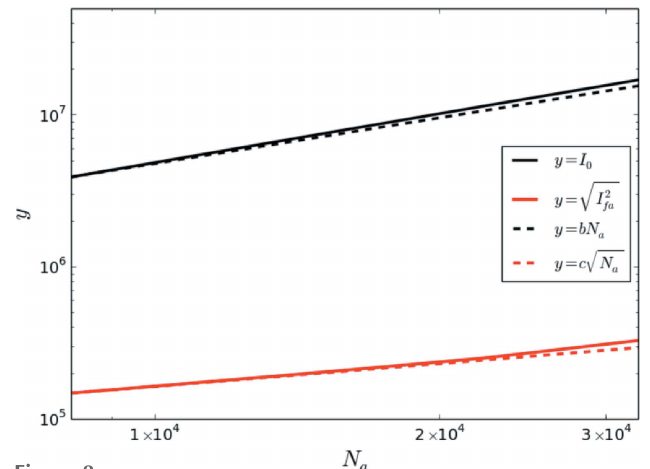
Figure 8 The scaling of I given to indicate the scaling, where the parameters b and c are fixed so that the plots are equal to the simulations at N a radius of 30 A˚